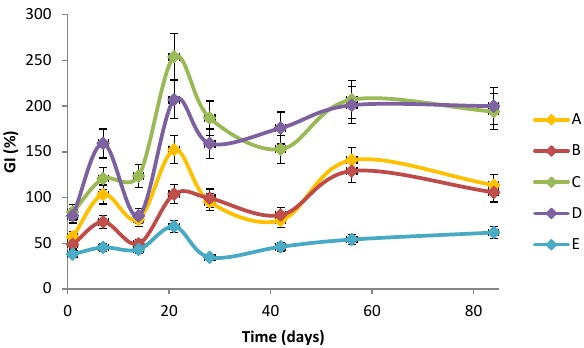
Figure 7. Changes of phytotoxicity in the remediated soil (A, B, C, D, E – as in Fig.